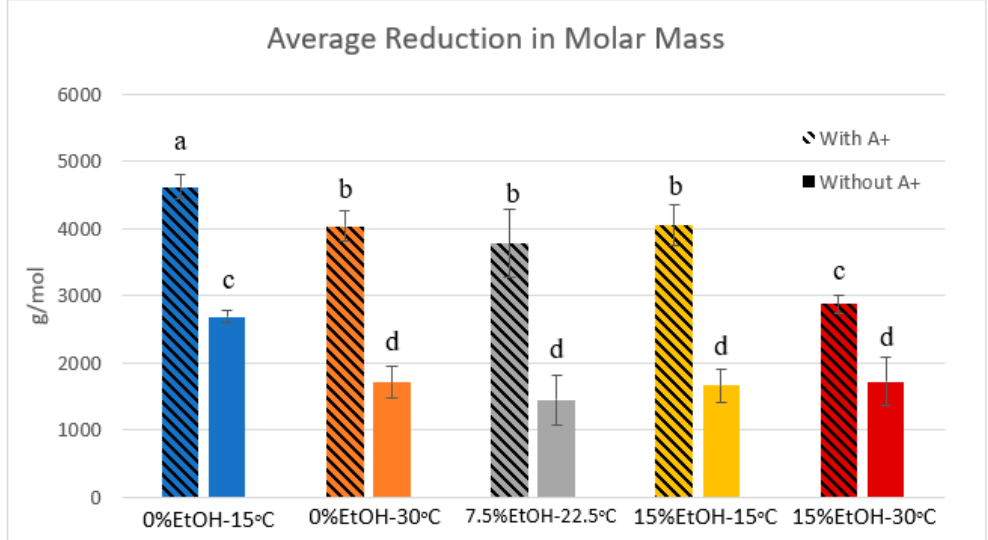
Figure 8. Average reduction in molar mass of PA solutions due to adsorption. Values calculated from average decrease between control sample Molar Mass and trial sample Molar Mass ( n = 9). All “Without A+” values were derived from a previous study [7]. Significant differences denoted by lowercase letters ( p < 0.05). “A+” = anthocyanins.